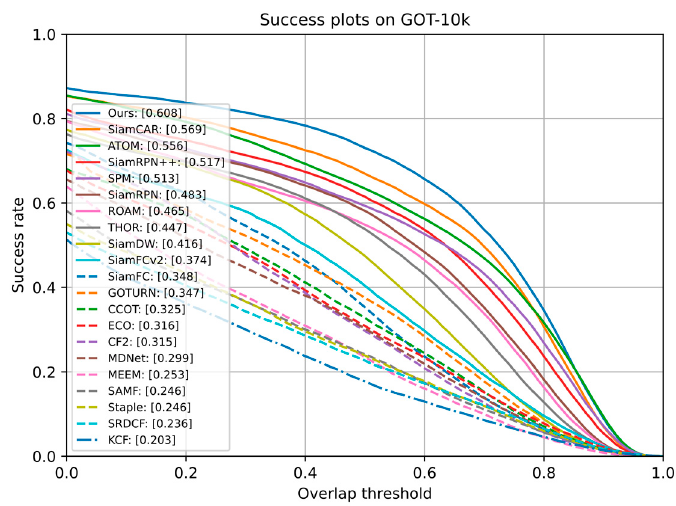
Figure 10. Comparison results on the GOT-10k benchmark.